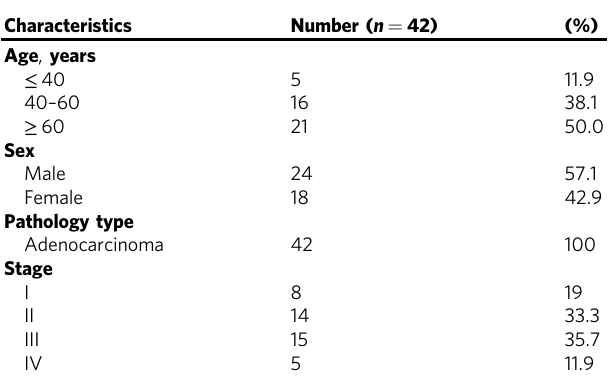
Table 1 Characteristics of colon cancer patients used for